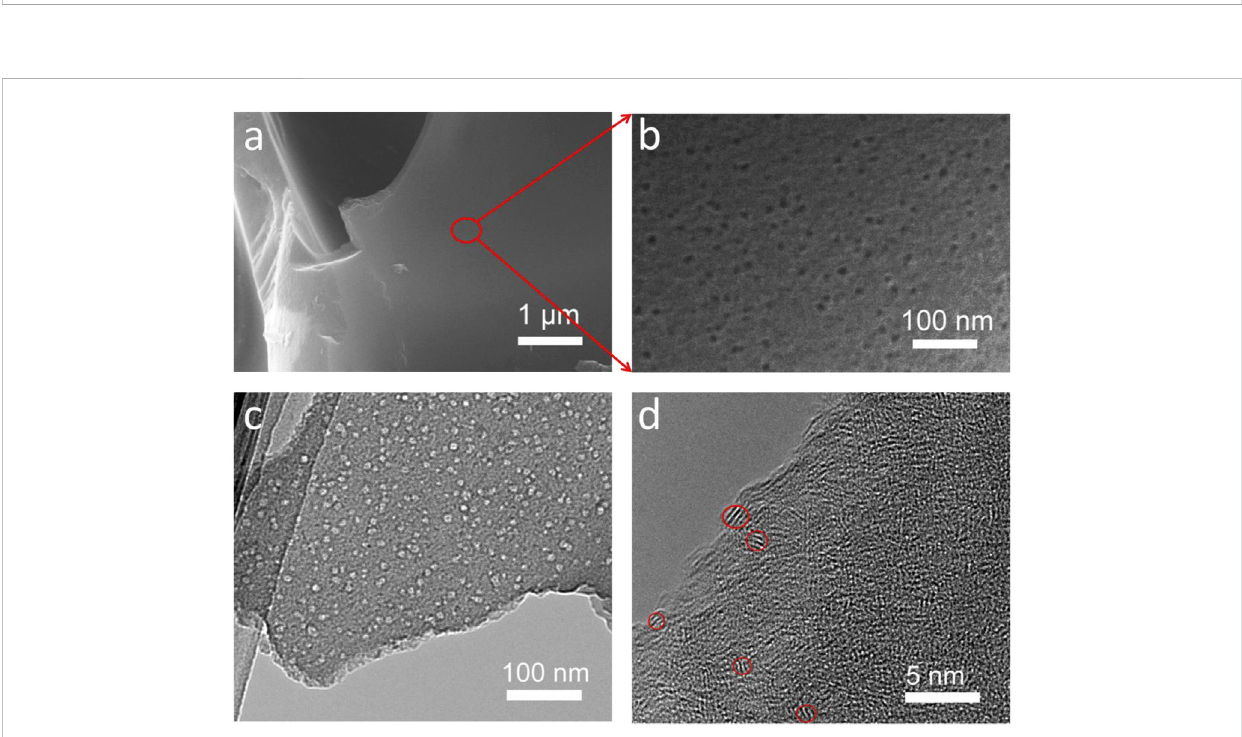
FIGURE 4 Representation of PBPC-1000: (A, B) SEM images, (C) TEM images, and (D) high-resolution TEM images (Cao, et al., 2018).